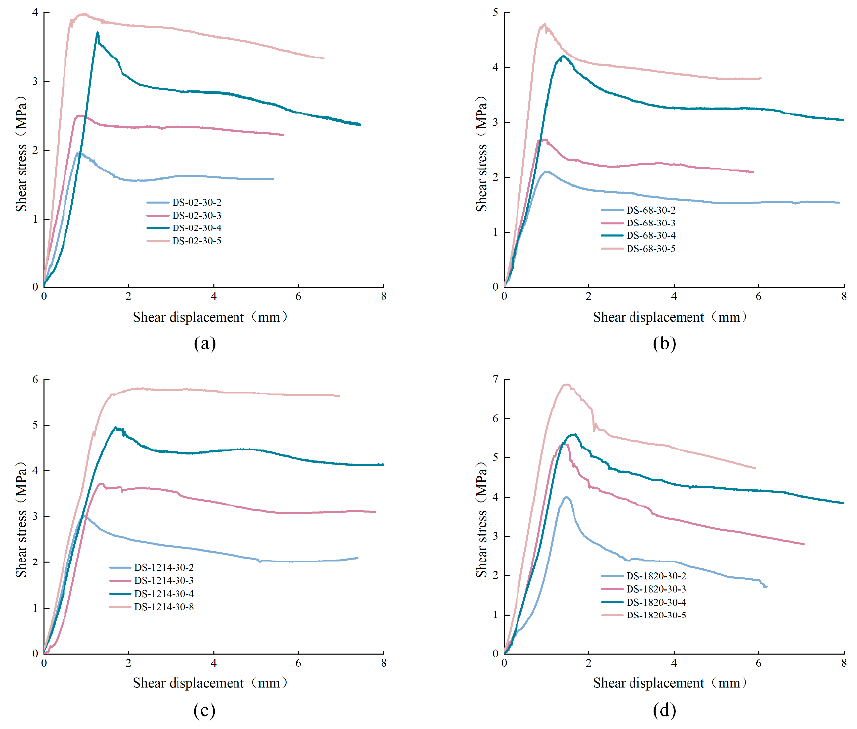
Figure 9. Shear stress-displacement curves of anchored structural planes with different JRC: ( a ) JRC = 0–2, ( b ) JRC = 6–8, ( c ) JRC = 12–14, ( d ) JRC = 18–20 (Specimen ID: DS-ab- α - σ , where DS represents direct shear experiment, ab represents the range of JRC, α means the anchorage angle, and σ means the normal